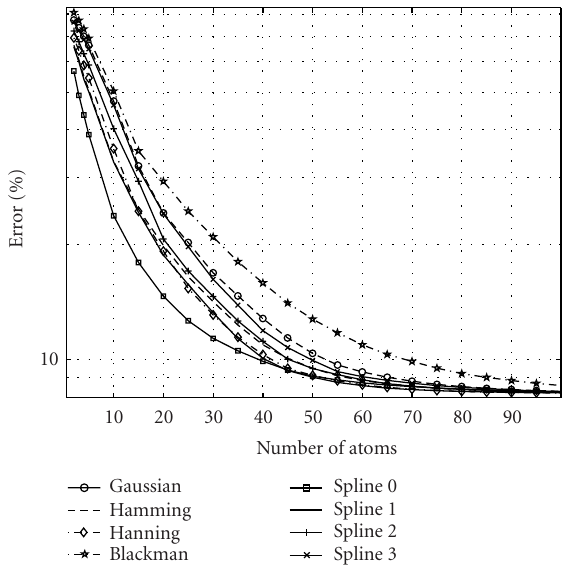
Figure 1: Reconstruction error versus number of atoms of the matching pursuit decomposition for each shape of the even real function k ( t ) (in logarithmic